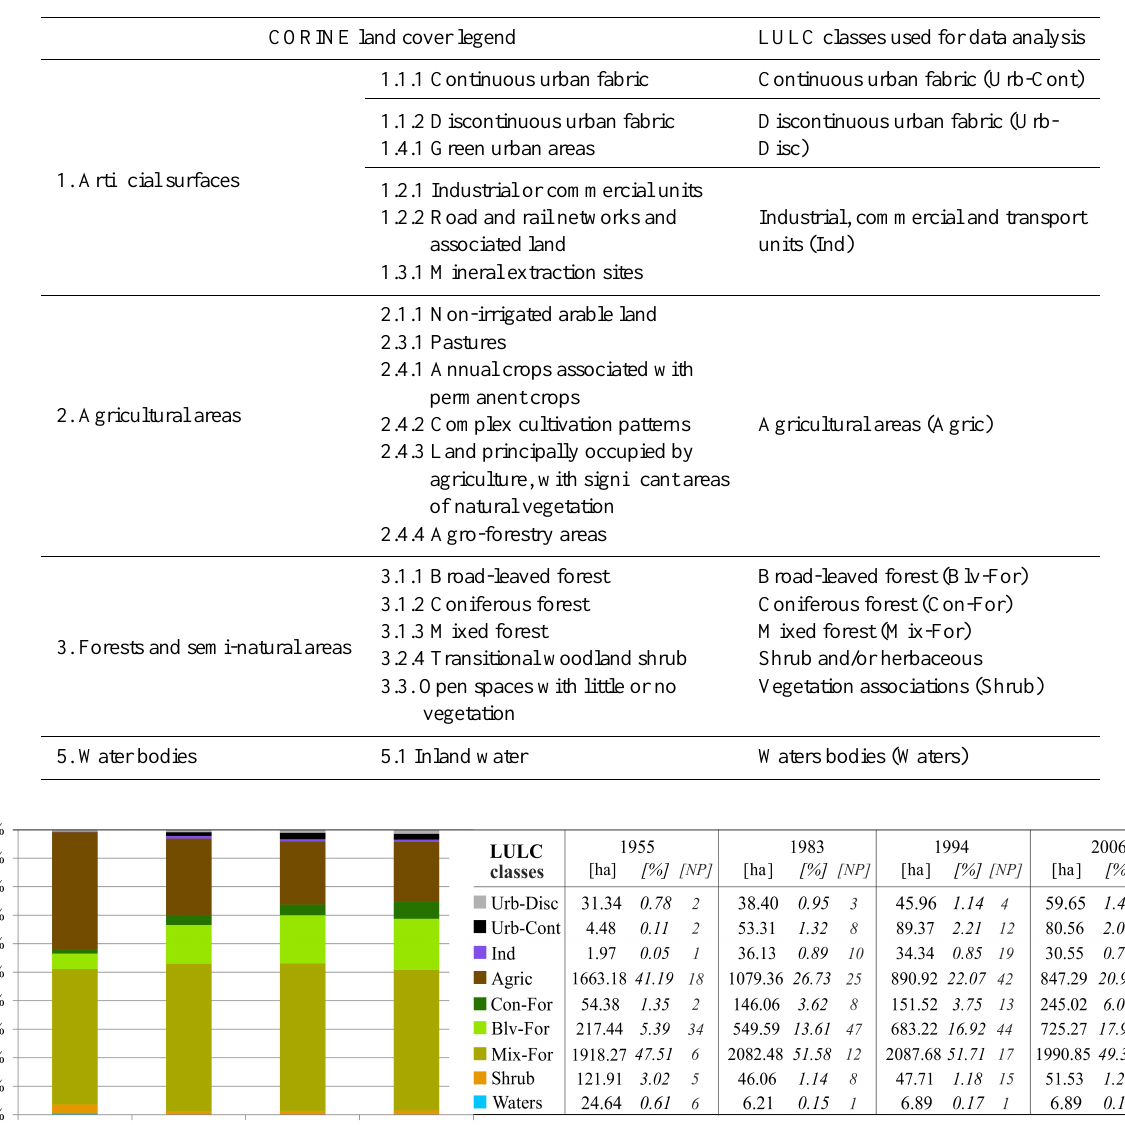
Table 1. Correspondence between CORINE legend nomenclature and LULC classes used for detecting LULC changes. In brackets, the symbols utilised in the text and in following figures.